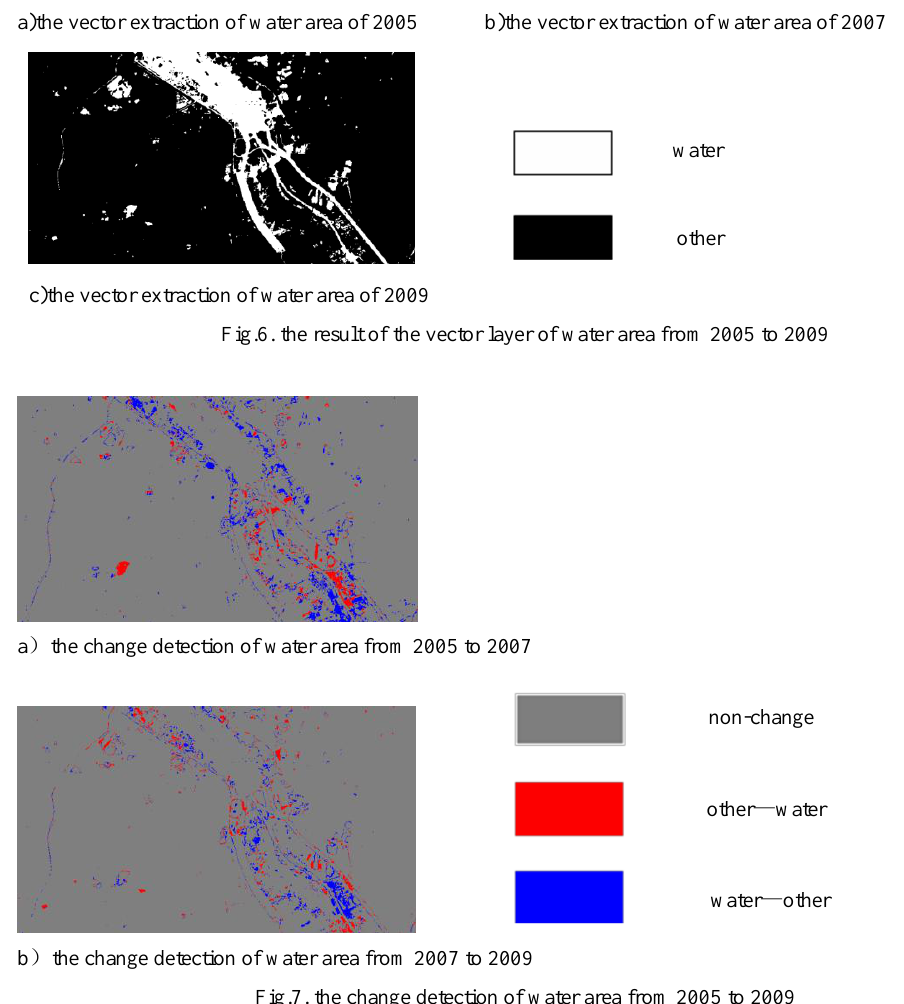
Fig.7. the change detection of water area from 2005 to